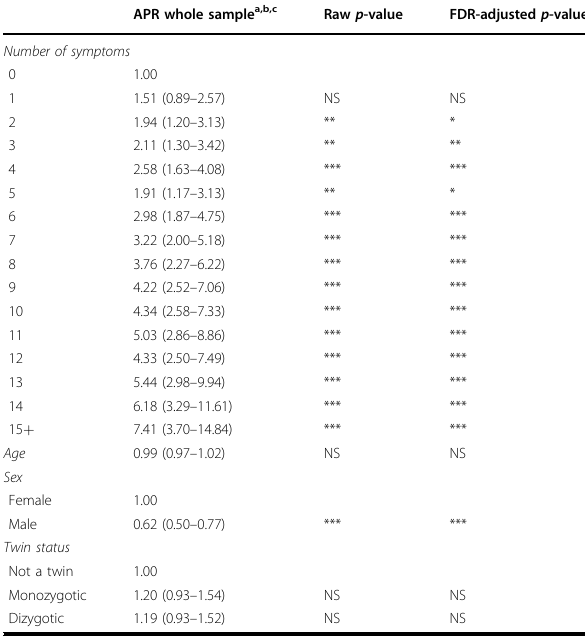
Table 3 Relationships between number of “ undifferentiated ” symptoms and “ days out of role ” in a community sample of young